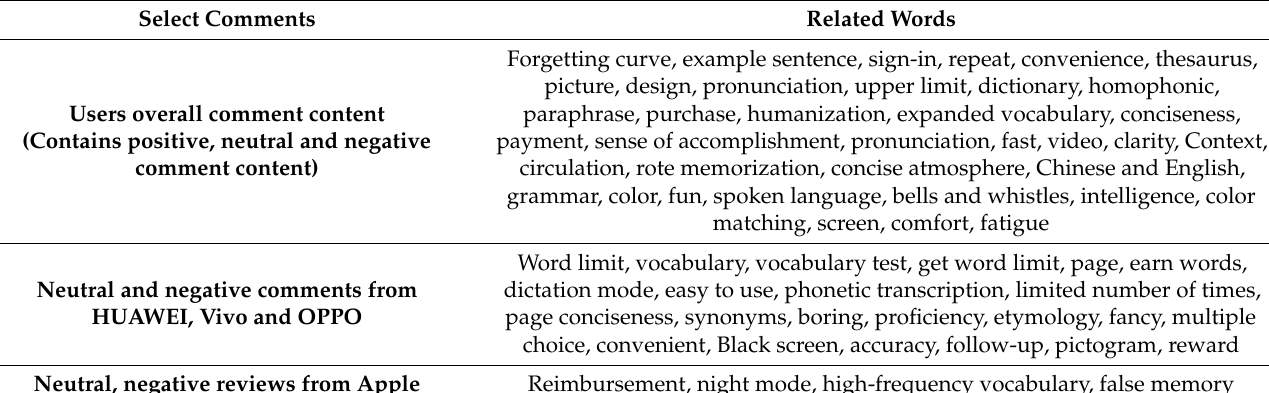
Table 4. MoMoBeiDanCi comments on content hot high-frequency